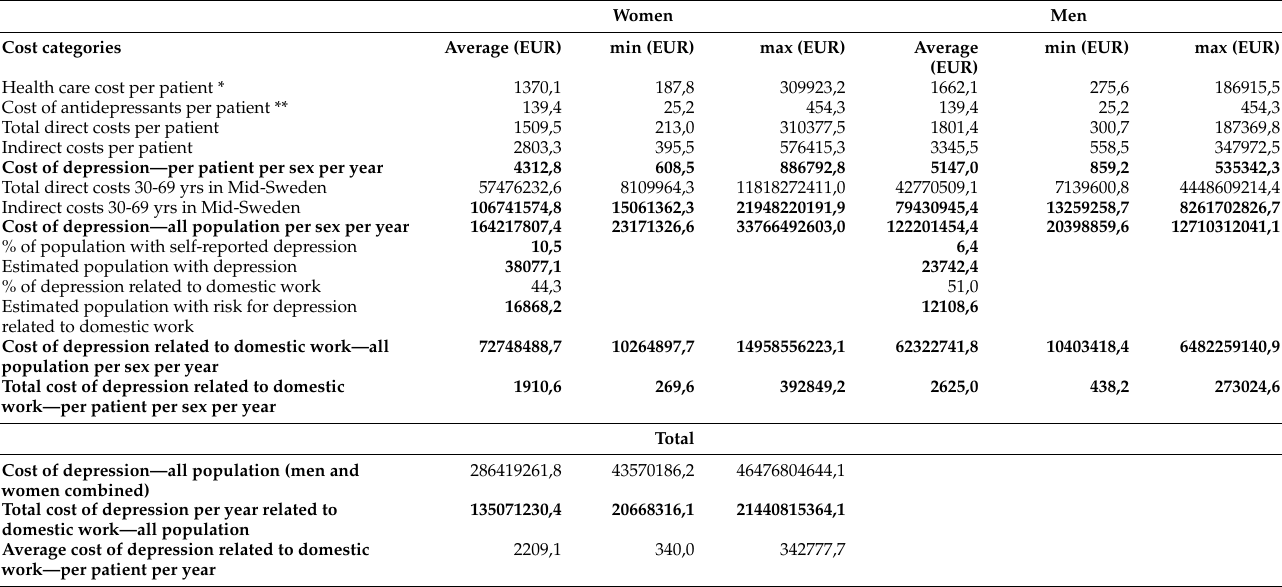
Table 4. Cost of depression and cost related to domestic work per year for men and women, and in total, aged 30–69 years in